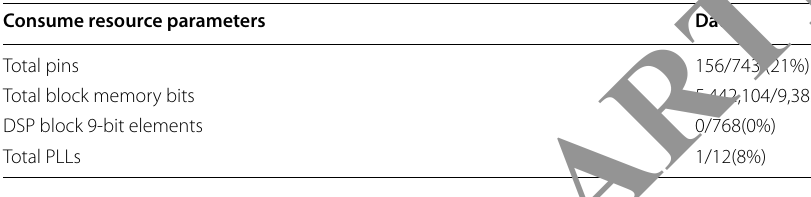
Table 5 Microprocessor development board resource consumption Consume resource